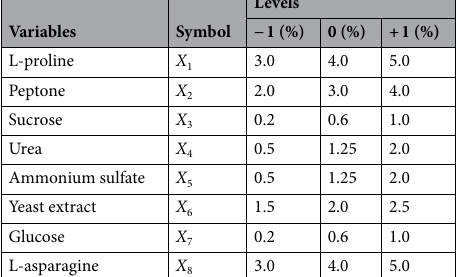
Variables Symbol